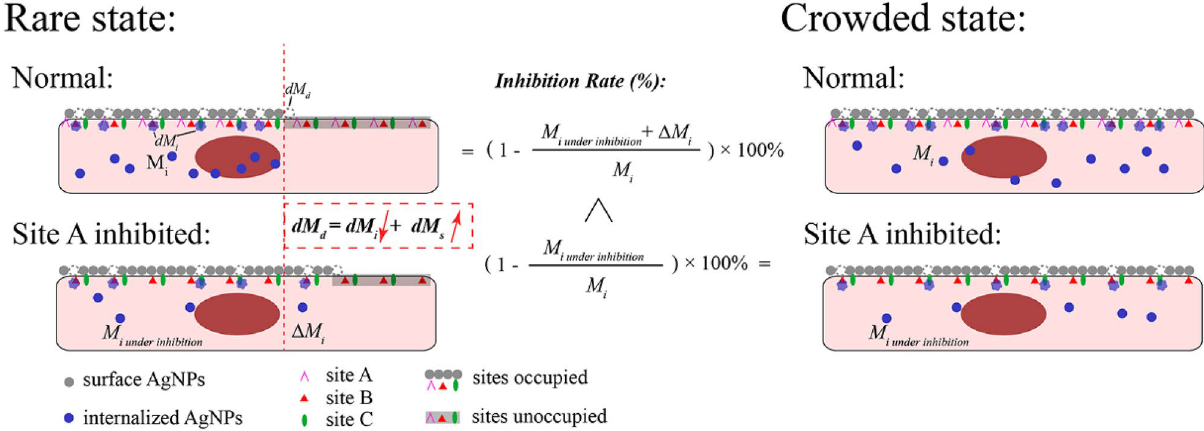
Figure 7. Schedule of the process of AgNPs entering normal A549 cell and the cell with site A inhibited to illuminate the difference of inhibition rate between “rare” state and “crowded”